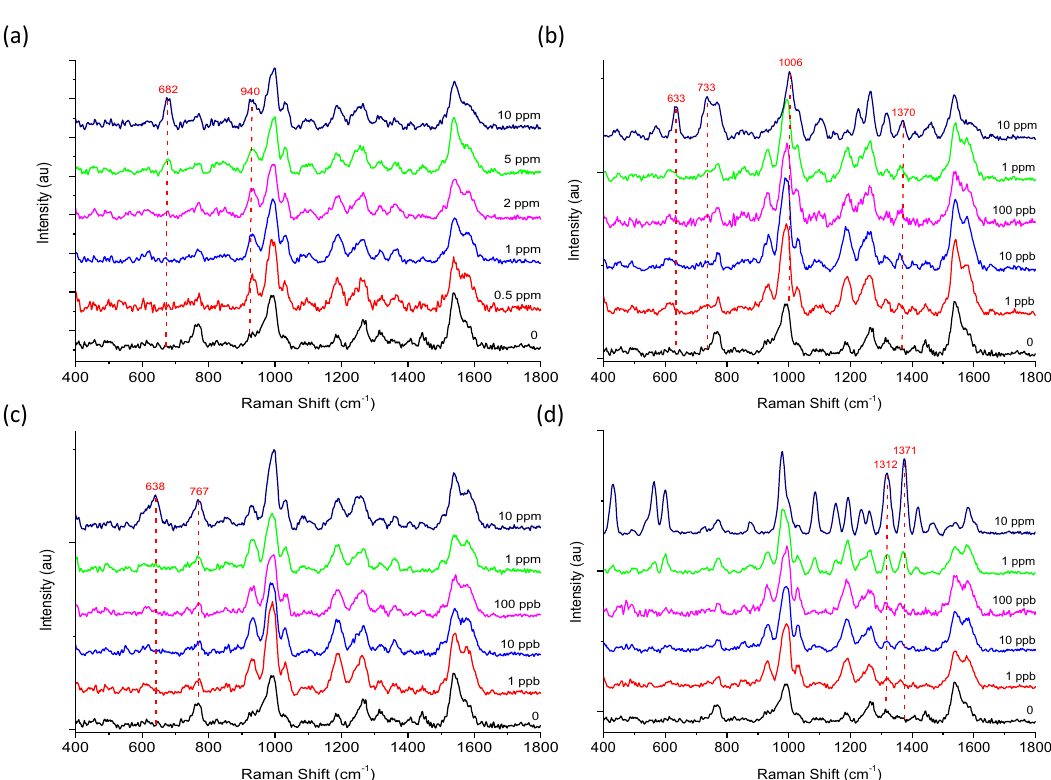
Fig. 6 Pesticide residues at different concentrations detected in basmati rice using SERS. Spectrum of ( a ) ACE, (b) CBM, ( c ) THI and ( d ) TRI obtained using handheld-SERS after extracting from spiked basmati rice using QuEChERs acetate